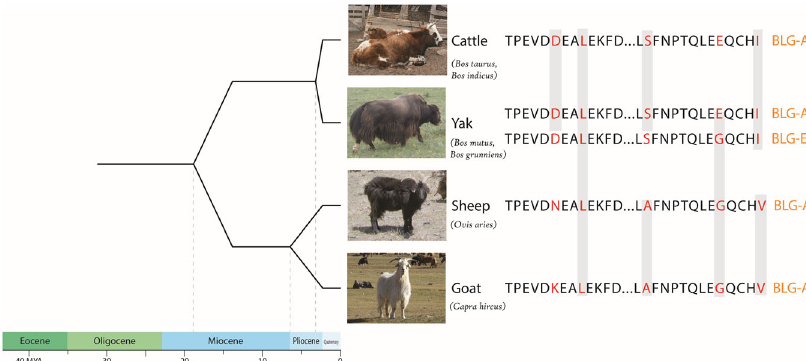
Fig. 2 Alignment of two tryptic BLG peptides that allow for species differentiation. The second yak peptide represents the last peptide (14 amino acids), which allows for the identi fi cation of Bos grunniens / mutus (BLG-E) (36). Here we compare the sequences from several key dairy animals (cattle, yak, sheep, and goat) to demonstrate the increasing sequence differences as species diverge phylogenetically. Accession codes in UniProt for BLG A is P02754 (shown in UniProt as Bos taurus), and BLG E is L8J1Z0 (shown in UniProt as Bos mutus